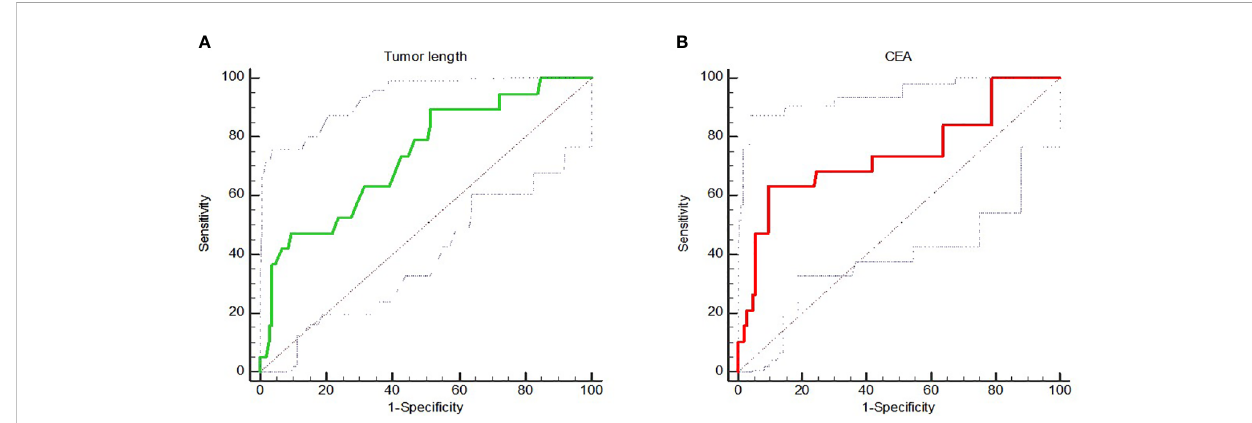
FIGURE 1 (A) showed the ROC analysis of correlation between longitudinal length of tumor measured by MRI and pCR; (B) showed the ROC analysis of correlation between CEA level and